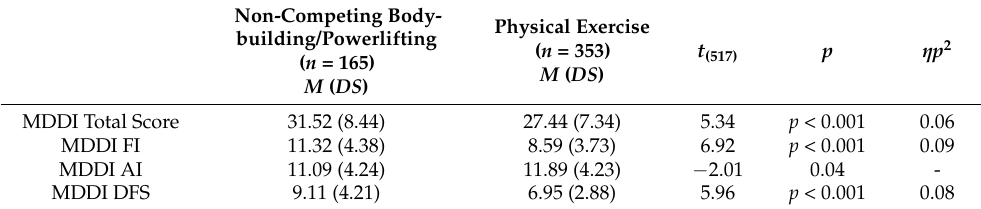
Table 5. Differences between groups on MDDI total score and